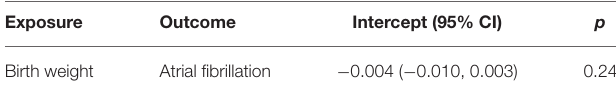
TABLE 1 | MR-Egger intercept test of the causal association between birth weight and atrial fibrillation.